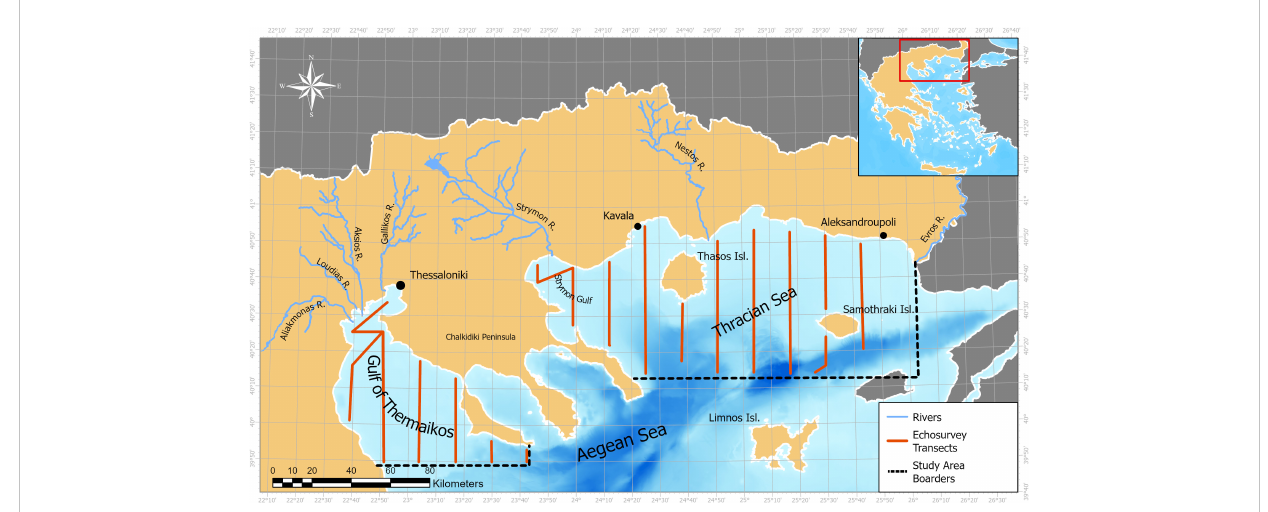
FIGURE 2 Map of the study area in the North Aegean Sea. The two examined sub-regions are the Gulf of Thermaikos in the West and the Thracian Sea in the